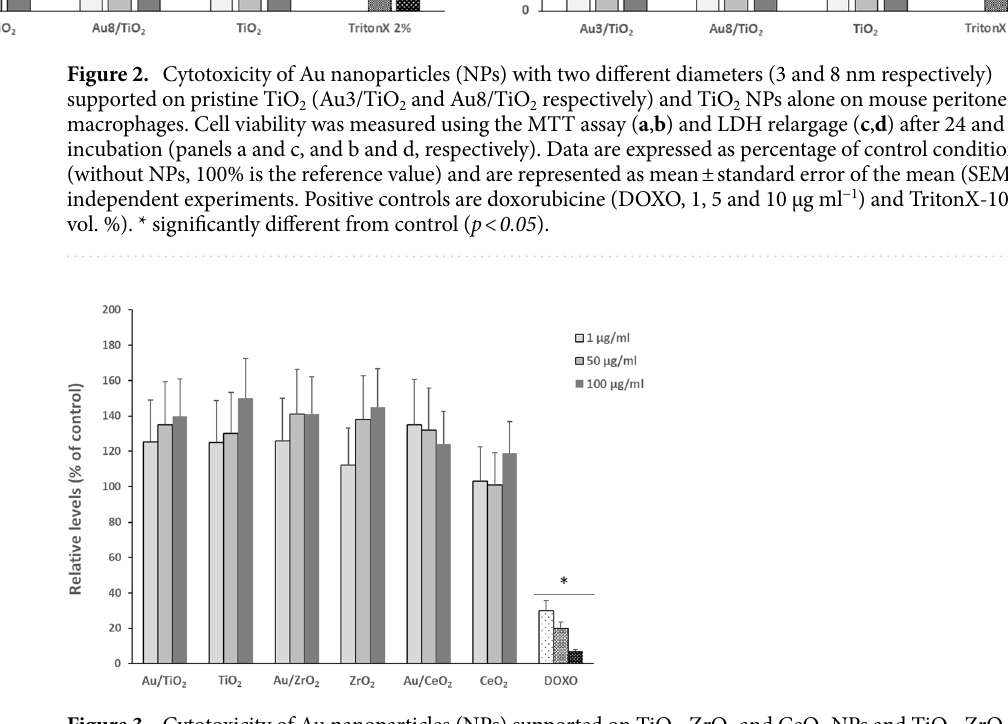
Figure 3. Cytotoxicity of Au nanoparticles (NPs) supported on TiO 2 , ZrO 2 and CeO 2 NPs and TiO 2 , ZrO 2 and CeO 2 NPs alone on mouse peritoneal macrophages. Cell viability was measured using the WST-1 assay after 24 h incubation. Data are expressed as percentage of control condition (without NPs, 100% is the reference value) and are represented as mean ± SEM of 6 independent experiments. Positive control is doxorubicine (DOXO, 1, 5 and 10 µg ml −1 ) * significantly different from control ( p < 0.05